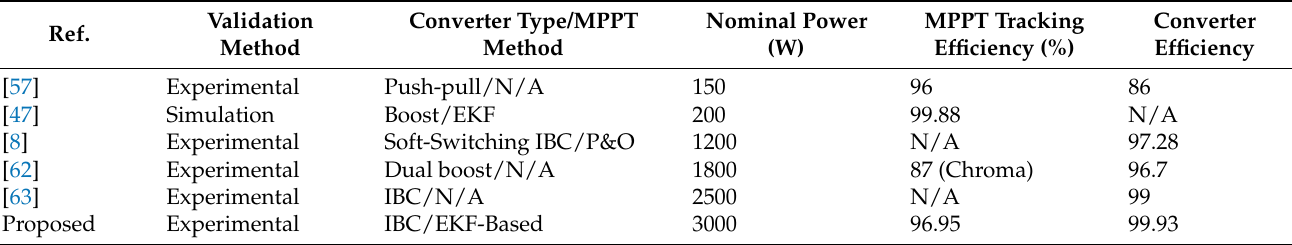
Table 4. Comparison of the proposed converter and MPPT controller with